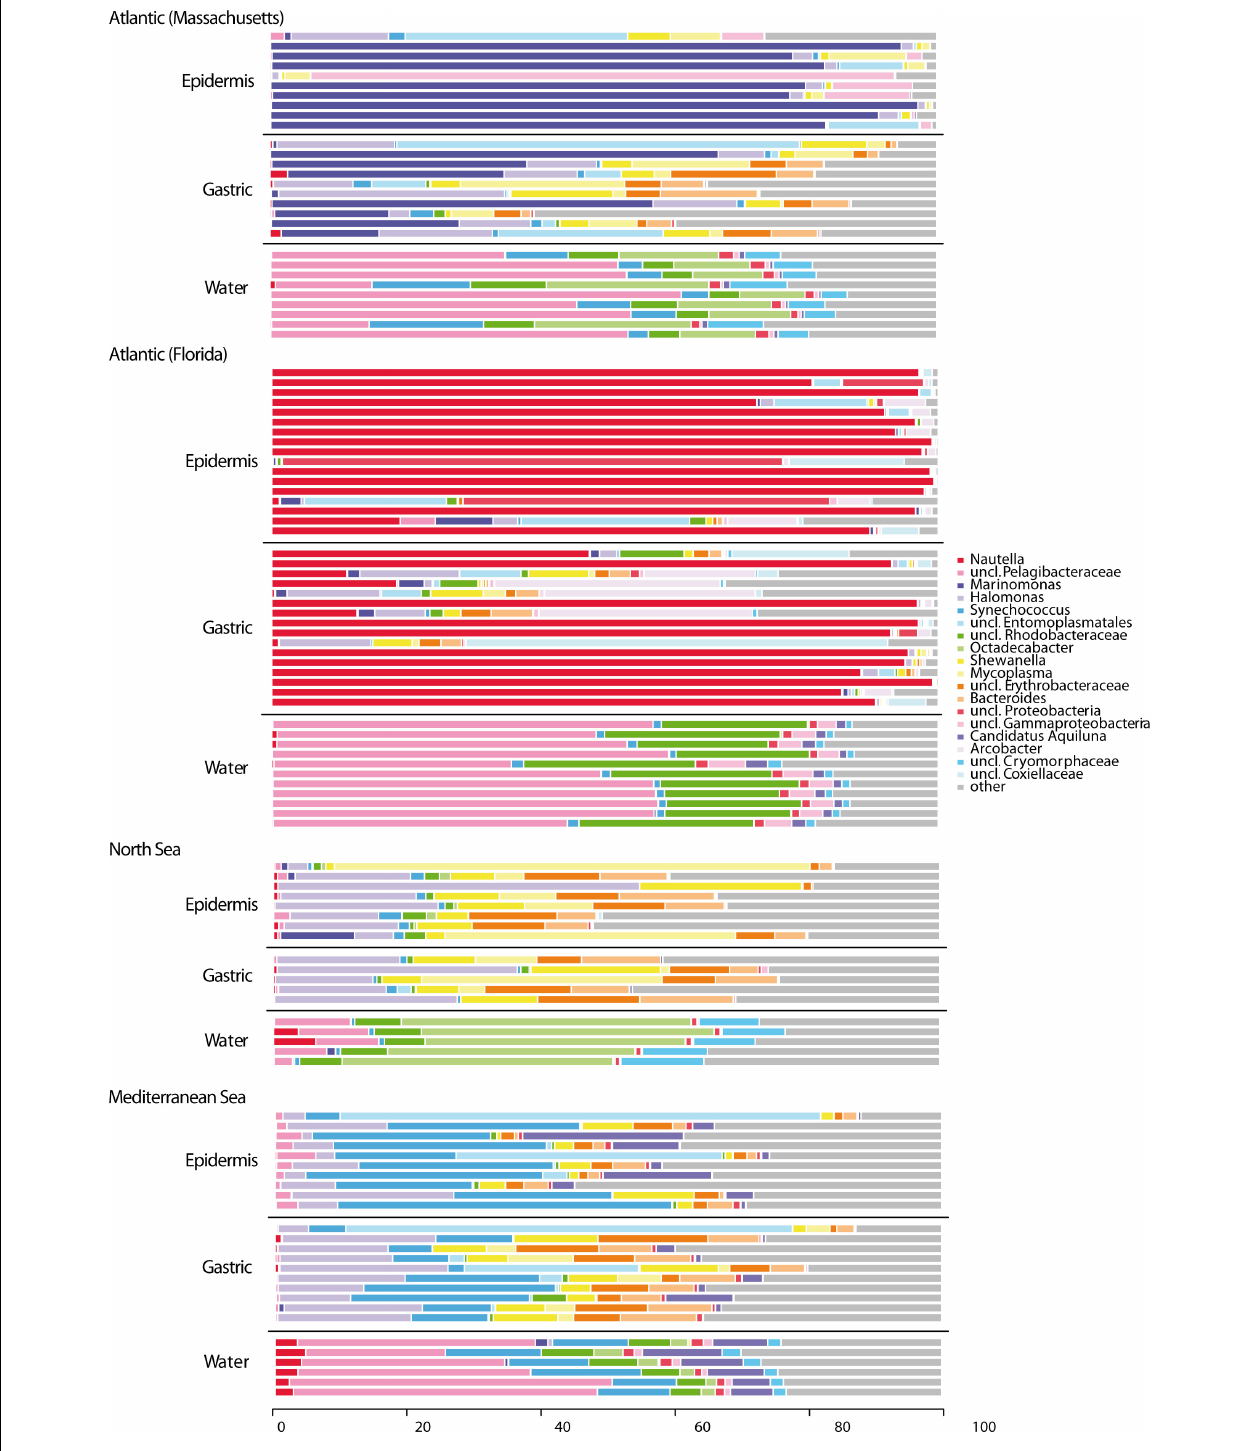
FIGURE 1 | Bacterial composition patterns of individual Mnemiopsis leidyi samples. Microbial communities associated with different epithelia of several sub-populations (native and invasive) of M. leidyi were analyzed by sequencing the V1-V2 hypervariable regions of the bacterial 16S rRNA gene. Taxonomic assemblages inferred from non-chimeric operational taxonomic units (OTUs) using mothur at a 97% pairwise similarity cut-off; distribution patterns were calculated using R. OTU abundances were summarized at genus level. Bar plots are grouped according to the sample type characteristic “provenance”, splitted into “epidermis”, “gastric” and “water” each including at least five replicates. Taxa with a mean relative abundance of < 1% across all samples are subsumed under “other”.